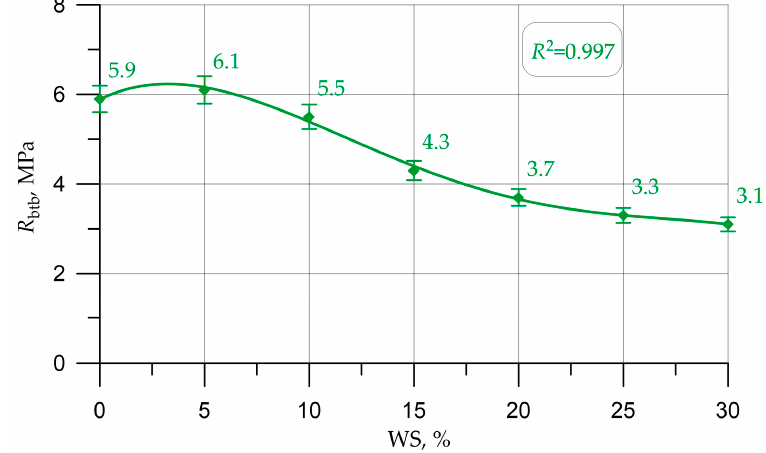
Figure 8. Dependence of the TS in bending of concrete on the amount of walnut shell.